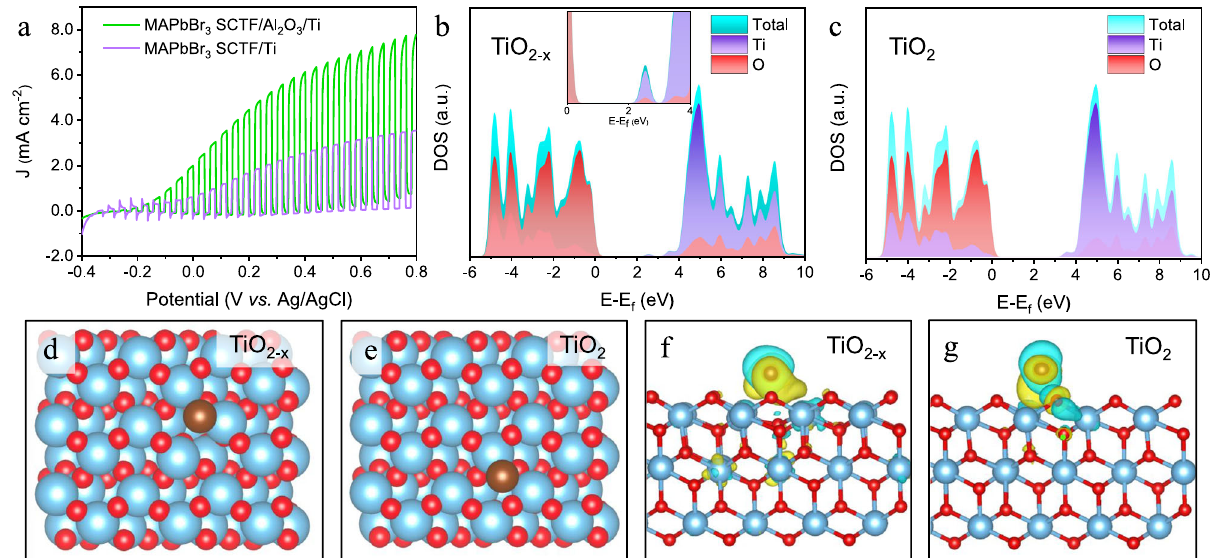
Fig. 6 Ti layer effect on the PEC performance. a PEC behaviors of MAPbBr 3 SCTF/Ti-based and MAPbBr 3 SCTF/Al 2 O 3 /Ti-based photoelectrodes. The projected DOS of b TiO 2 − x and c TiO 2 . DFT-calculated adsorption of Br on the surfaces of d TiO 2 − x and e TiO 2 . f , g Corresponding electron density difference, where yellow indicates a gain of electrons and cyan indicates loss of